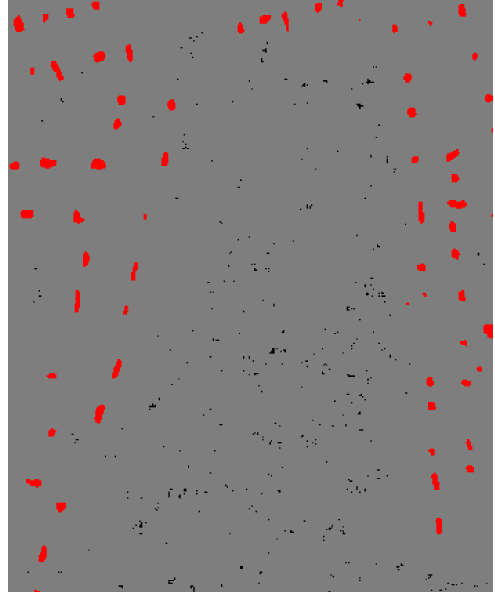
Figure 12. Visual results of our Bayesian U-Net on a small area of the Massachusetts dataset. The pixels can be predicted with a desired level of confidence (here, greater than 20%, 50% and 90%). Color code: buildings , background , not